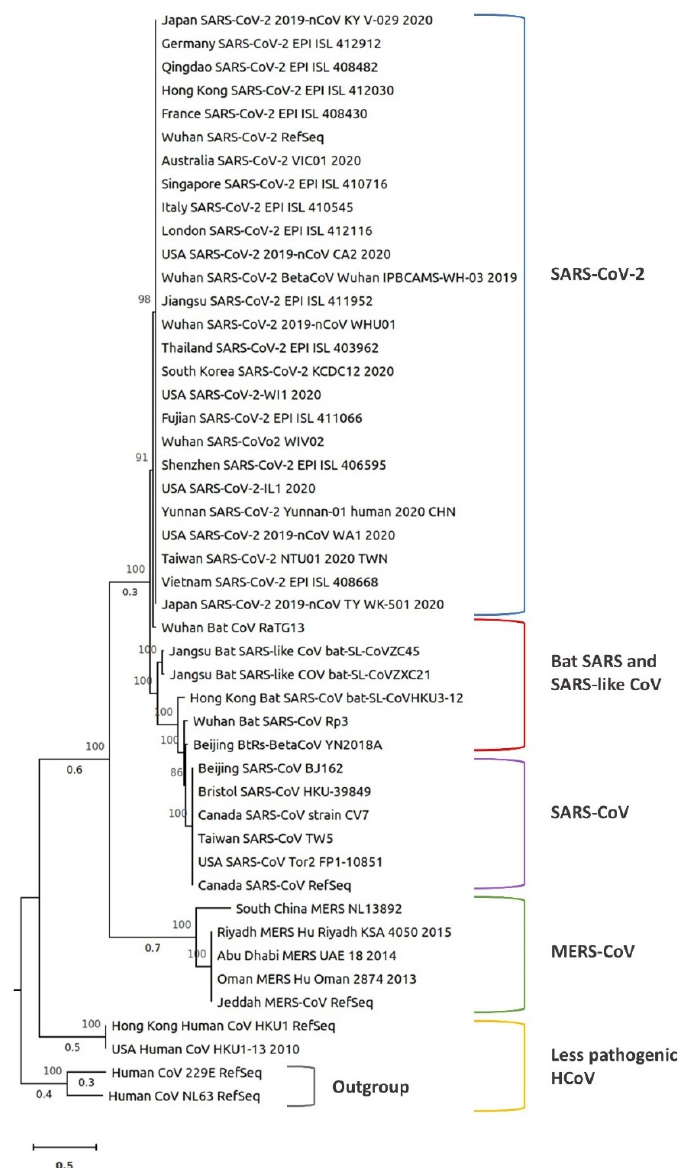
Figure 2. Phylogenetic tree based on the complete genome sequences of 45 selected coronaviruses from 18 countries including the SARS-CoV-2, SARS-CoV, HCoV, bat SARS, SARS-like CoV, and